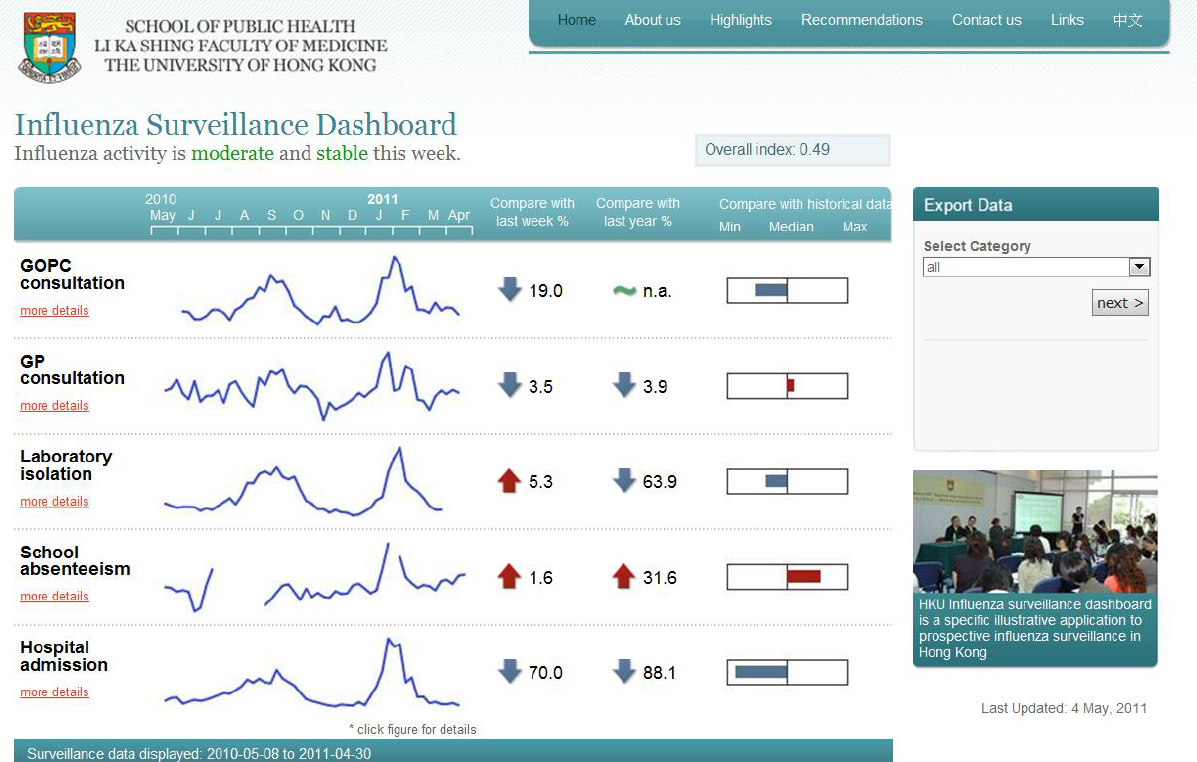
Figure 2. Screenshot of the main page of the influenza surveillance